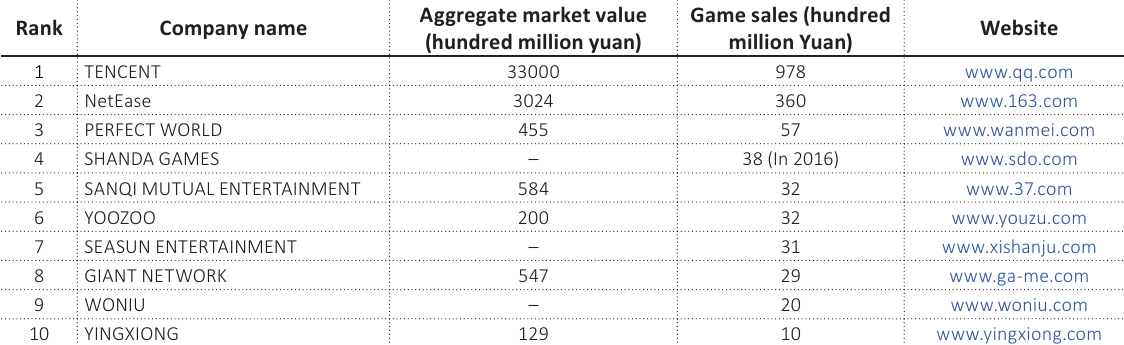
Table 1. Chinese game companies ranked by total sales